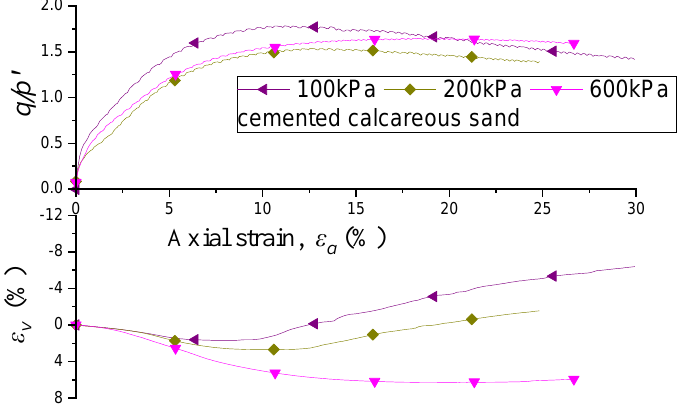
Figure 11. Stress ratio and volumetric strain behaviors of stabilized calcareous sand.